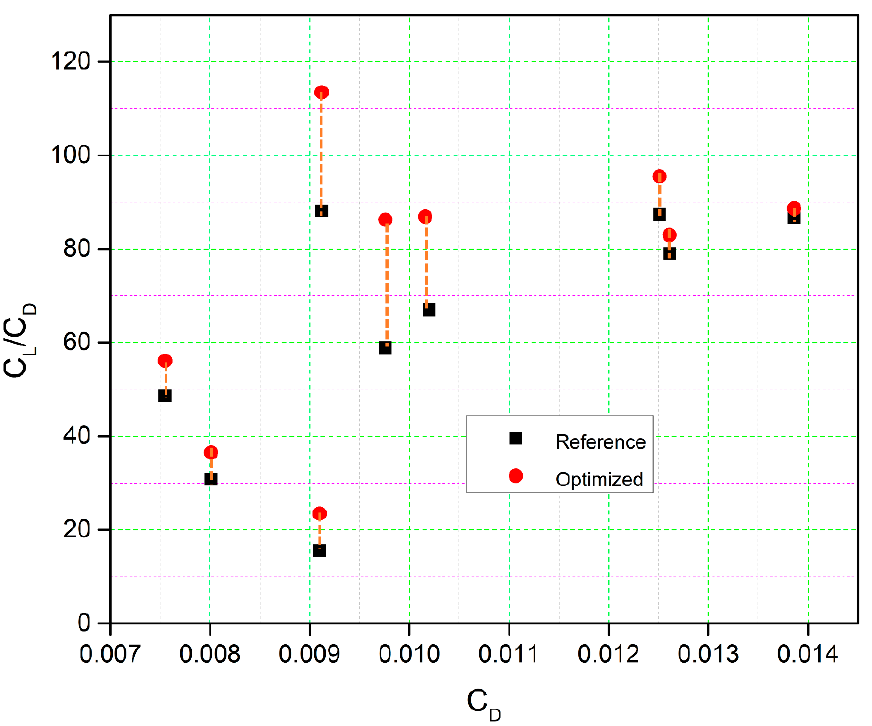
Figure 15. Increase in the lift-to-drag ratio at the same drag coefficient for the optimized airfoil versus the reference airfoil.